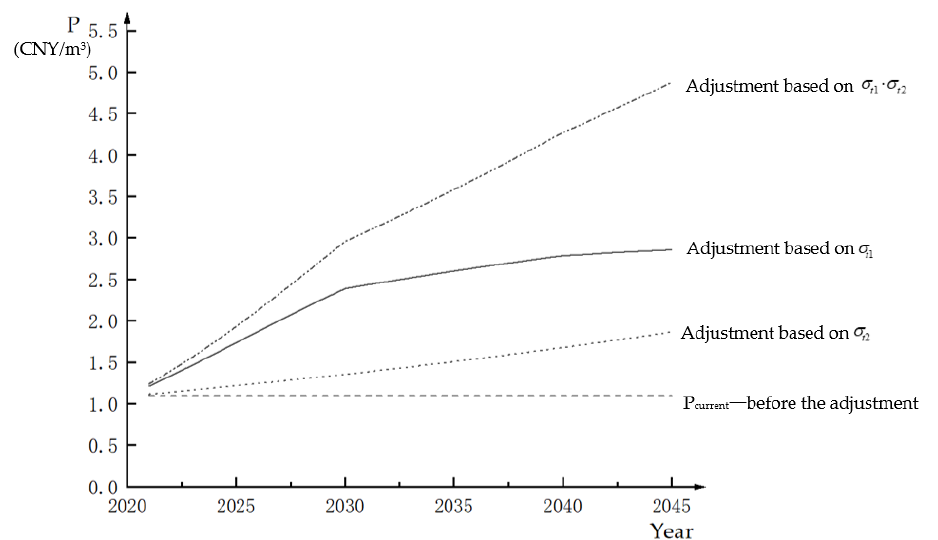
Figure 6. Dynamic change trend of the water right trading price in Helan from 2021 to 2045 under different adjustment elements.